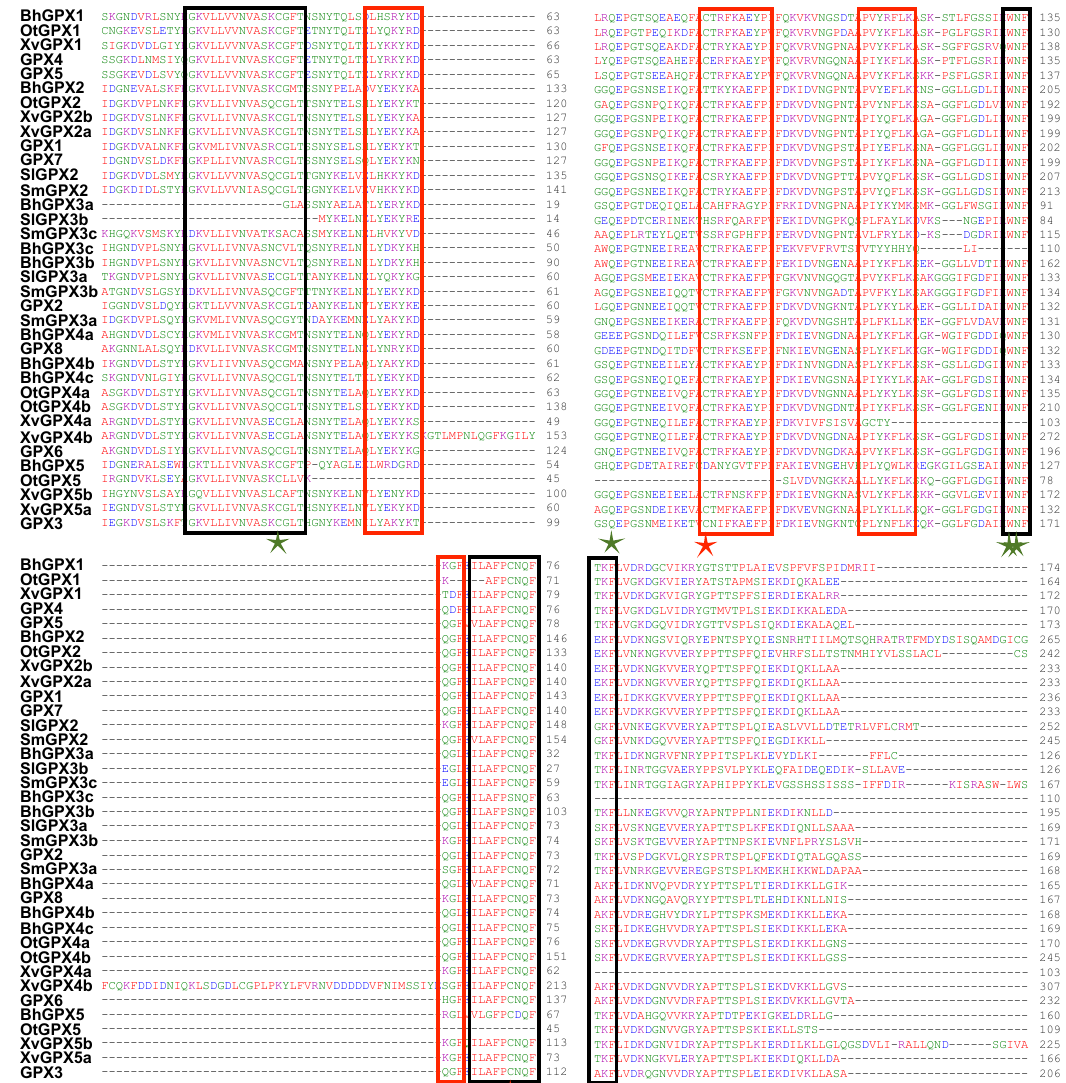
Figure 3. Multiple sequence alignment (MSA) of GPX proteins. MSA of the GPX members identified in Boea hygrometrica , Selaginella lepidophylla , Xerophyta viscosa , Oropetium thomaeum , and Selaginella moellendorffii along with the GPX proteins from Arabidopsis thaliana are shown. The black rectangles represent the three highly conserved GPX domains, red rectangles mark highly conserved short signatures, four green stars represent the catalytic amino acid residues and red stars represents other evolutionary conserved Cys residues.